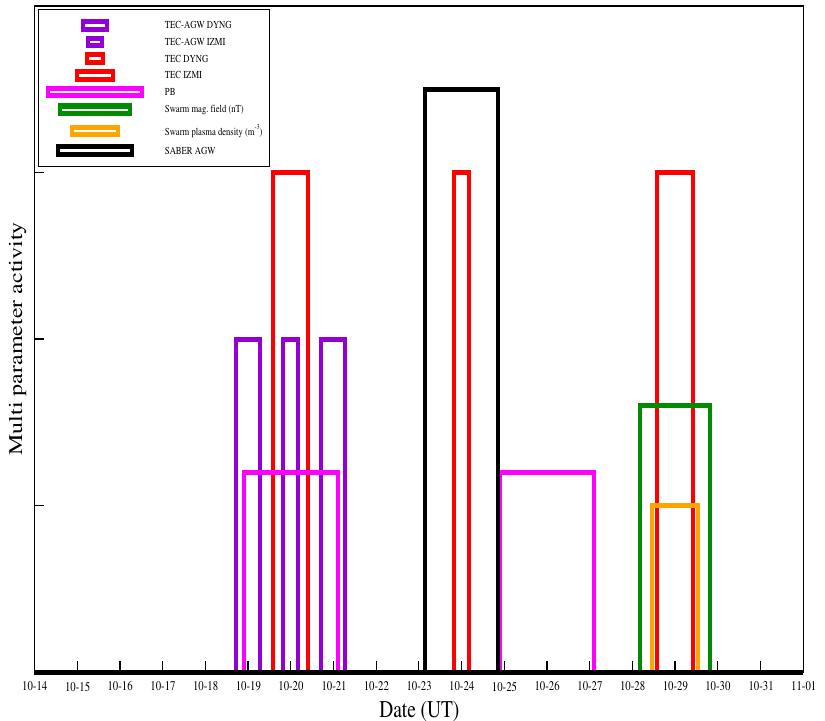
Figure 20. Temporal evolution of TEC-AGW (violet histogram), TEC (red histogram), PB (magenta histogram), swarm magnetic field (in nT) (green histogram), swarm plasma density (in m − 3 ) (orange histogram), SABER-AGW (black histogram) activities from multiparametric analysis. y -axis has no scale or units, it only indicates dates of multiparametric activity. The differences in the y -axis dimension only serve as a means of simple visual identification of the activity for the various parameters, especially in overlapping